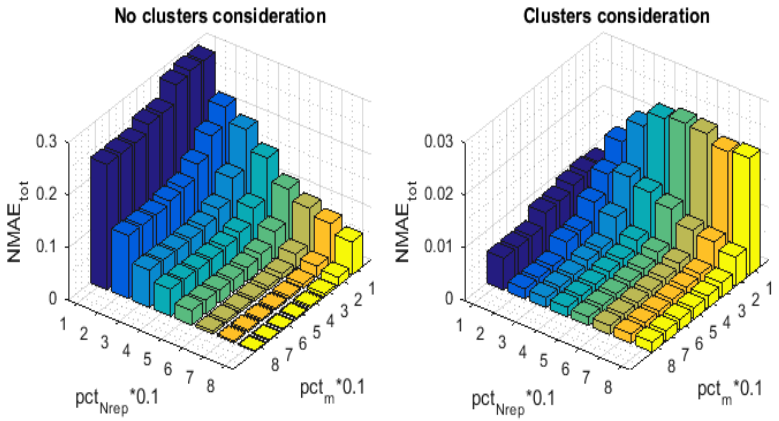
Figure 10. NMAE tot with and without clusters consideration.